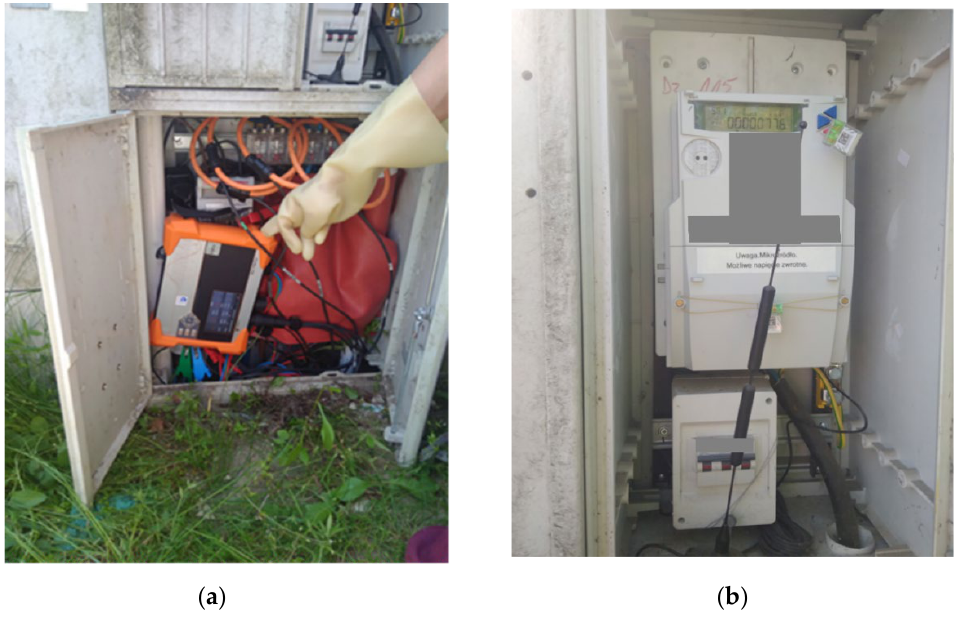
Figure 2. The installation site at PCC ( a ) PQ-BOX 200, ( b ) electric meter.